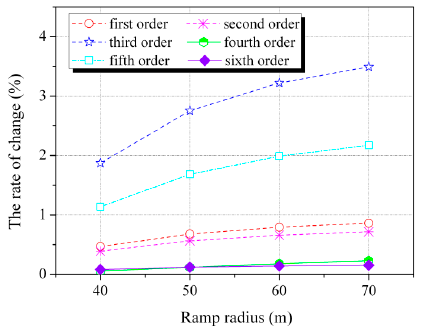
Figure 6. Change rates of modal frequencies with different ramp radii. Algorithms 2017 , 10 , 62